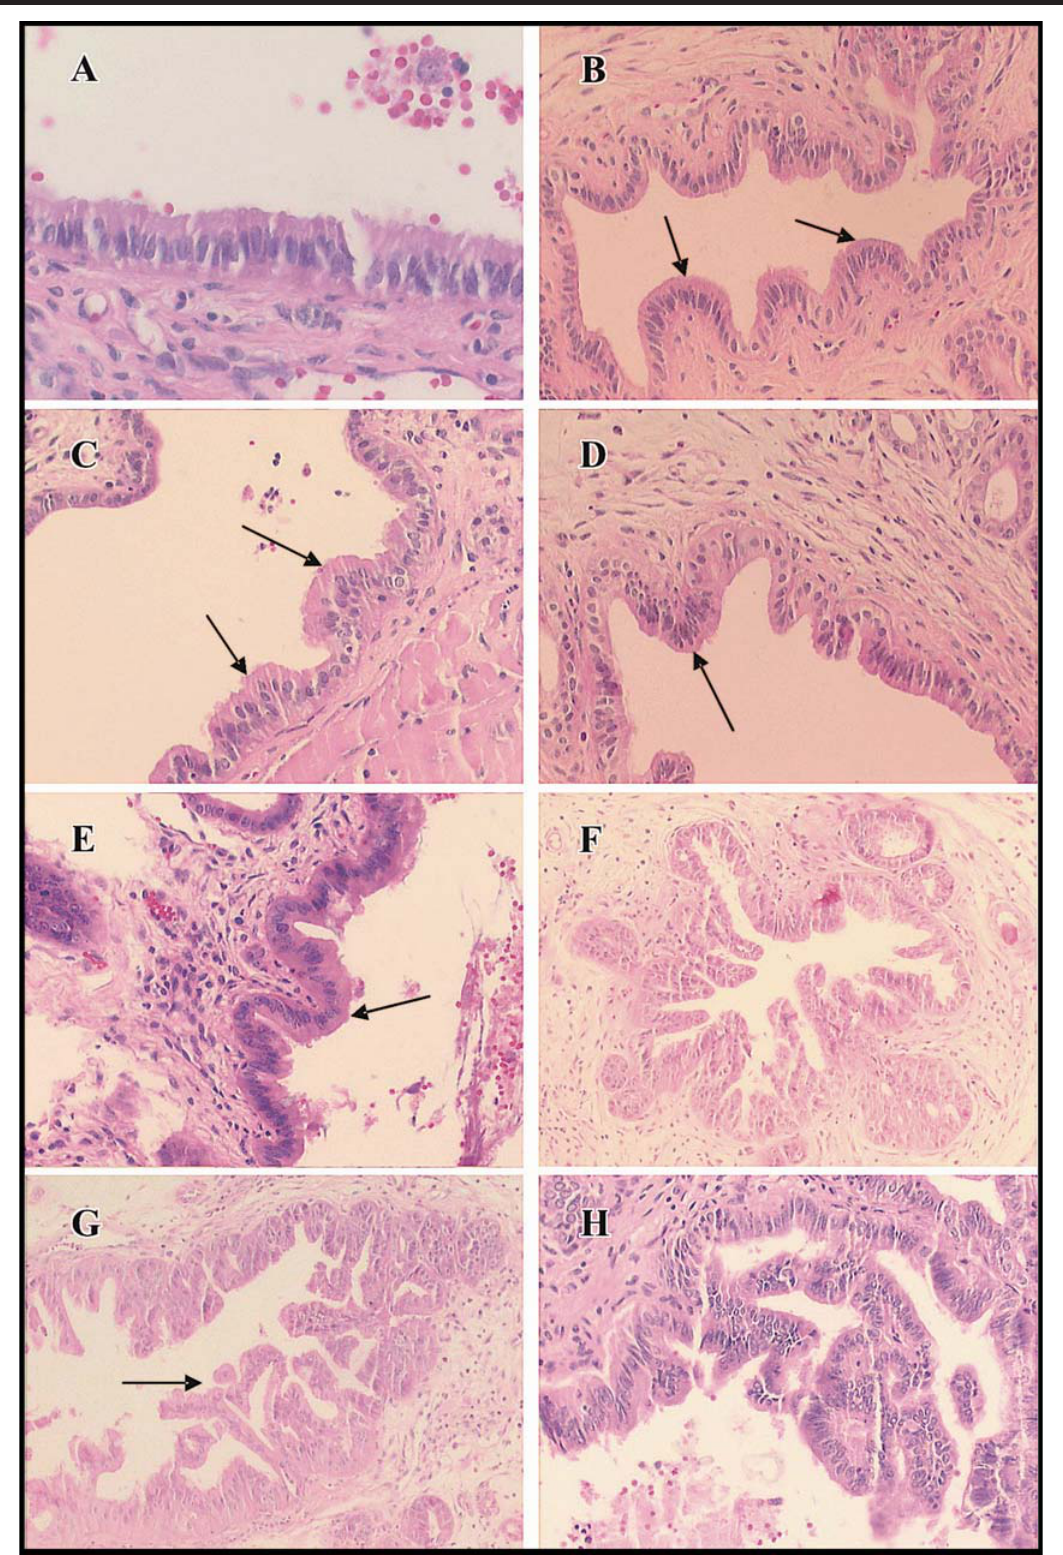
FIGURE 1 - Precursor lesions classified as PanIN: A) PanIN-1A with cylindrical epithelium, magnification of ×40 from the original; B) PanIN-1B with papillary projections (arrows), magnification of ×20 from the original; C) PanIN-1B with papillary projections (arrows), magnification of ×10 from the original; D) PanIN-2 with papillary projections with nucleuses at different heights (arrow), magnification of ×20 from the original; E) PanIN-2 with papillary projections (arrows), magnification of ×20 in the original; F) PanIN-3, magnification of ×10 from the original; G) PanIN-3 with decapitation (arrow), magnification of ×10 from the original; H) PanIN-3 with cribiform feature, magnification of ×20 from the original. Slides stained using the hematoxylin and eosin